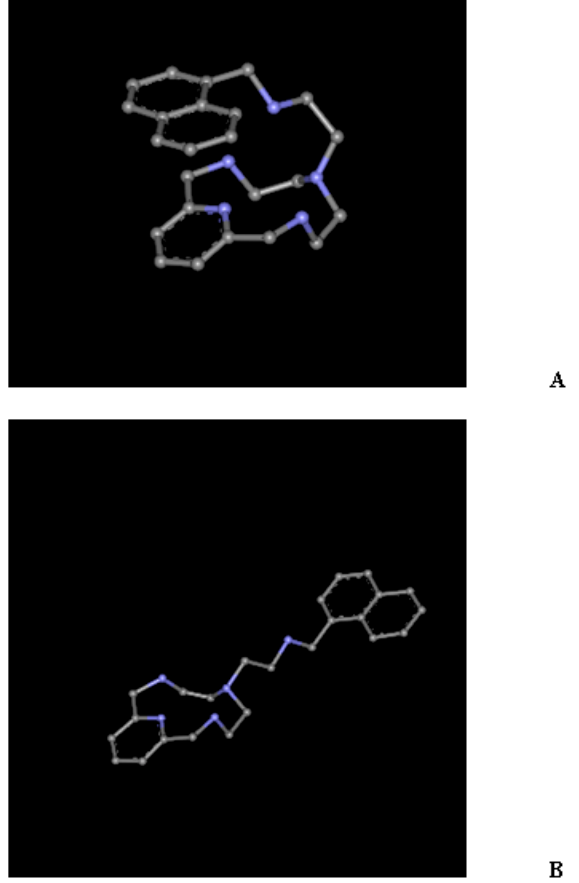
Figure 1. Conformations closed ( A ) and open ( B ) of the aza-scorpiand macrocycle studied.